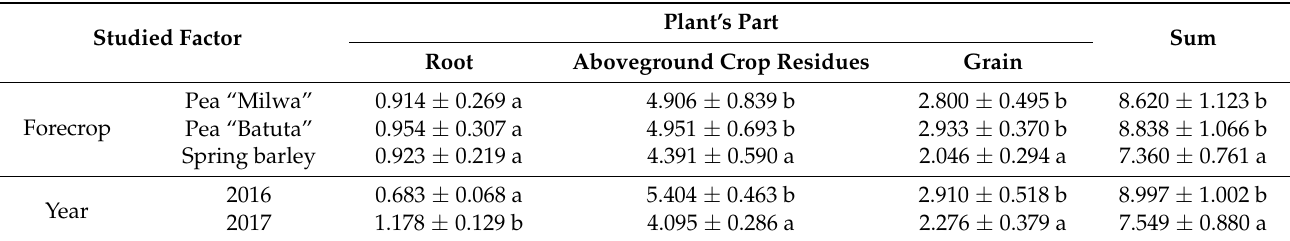
Table 4. Dry weight of winter triticale, Mg · ha − 1 (averages ± SD).